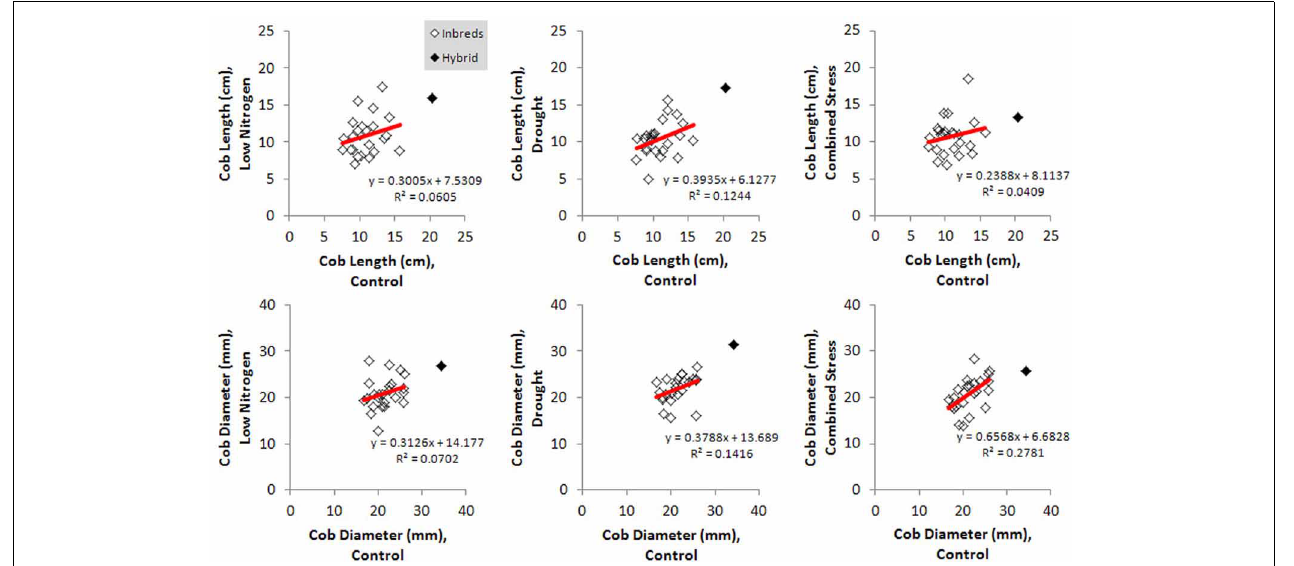
FIGURE 1 | Physiological responses to imposed environmental stress for all genotypes. Effect of environmental stress treatments on cob length and cob diameter are shown relative to the control